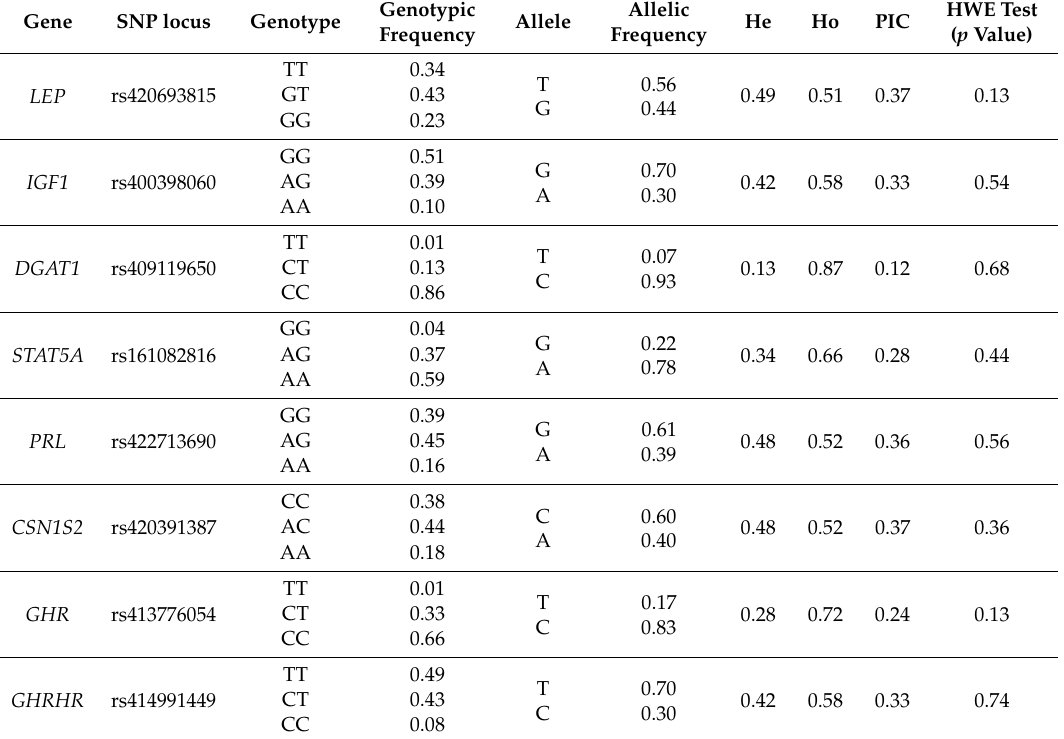
Table 5. Genetic parameters describing the SNP markers of the investigated candidate genes in the Barki lamb